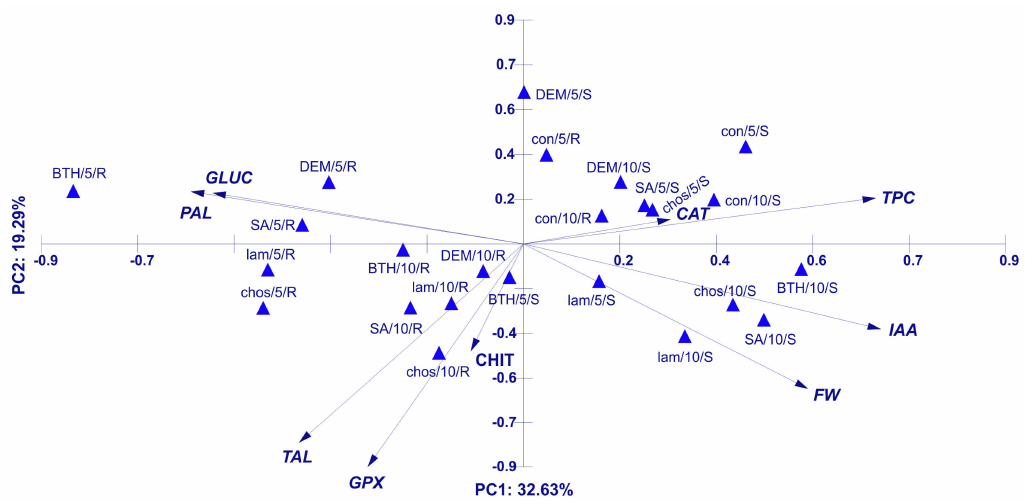
Figure 19. The ordination diagram showing the result of the PCA for the in vivo study parameters of the stems (S) and roots (R) of wheat seeds inoculated with the Trichoderma DEMTkZ3A0 strain conidia (DEM) and commercial elicitors: Chitosan (chos) and laminarin (lam) and non-inoculated